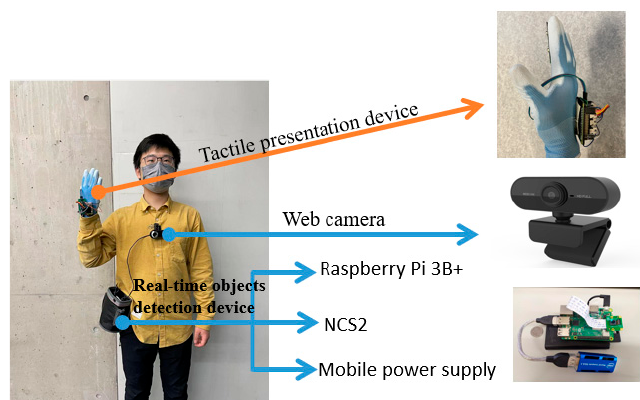
Figure 15. Subject wearing devices.